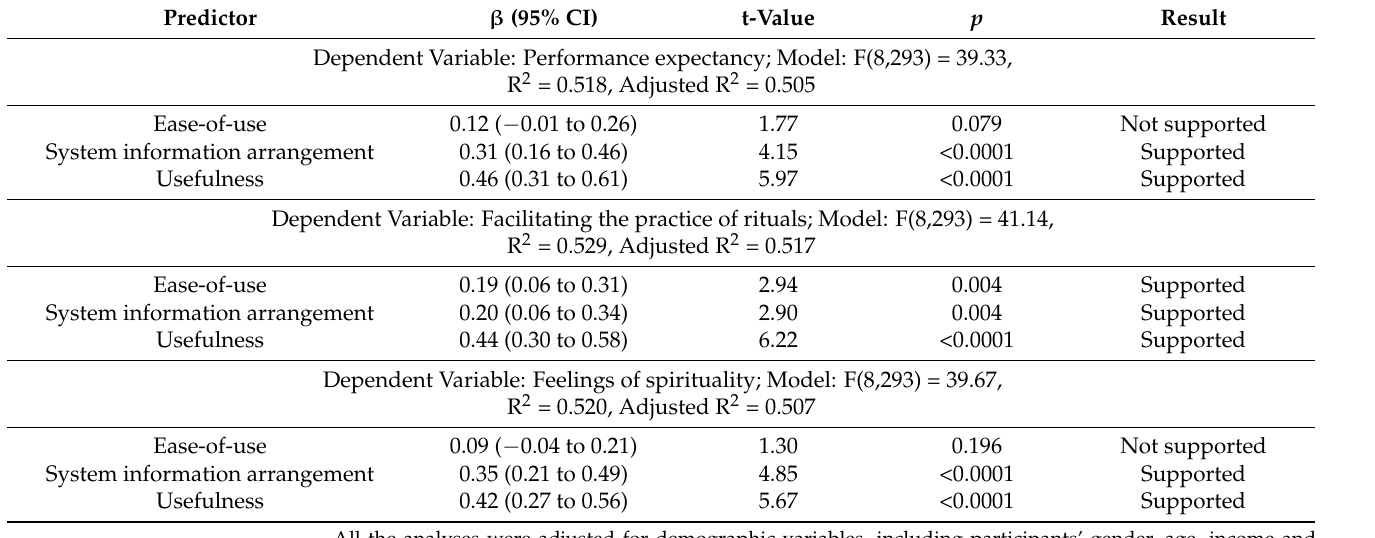
Table 4. The results of multiple linear regression analysis to assess the impact of three smartphone usability domains on improving Umrah experience.